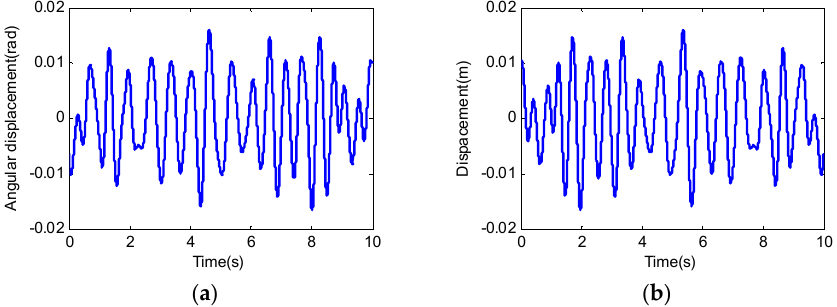
( f ) Figure 13. The velocity and angular velocity of the center position of the lower platform: ( a ) x -axis displacement; ( b ) y -axis displacement; ( c ) z -axis displacement; ( d ) rotation around the x -axis; ( e ) rotation around the y -axis; ( f ) rotation around the z -axis. ( a )